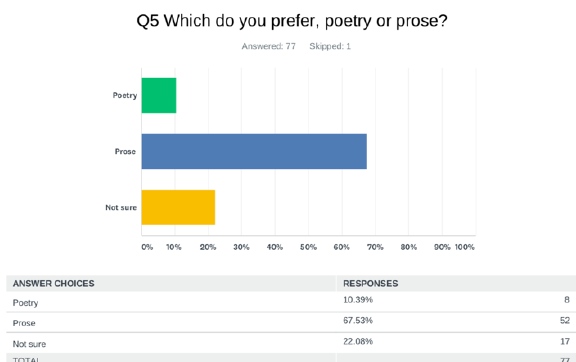
Figure 18 . Overall Summary, Question 4